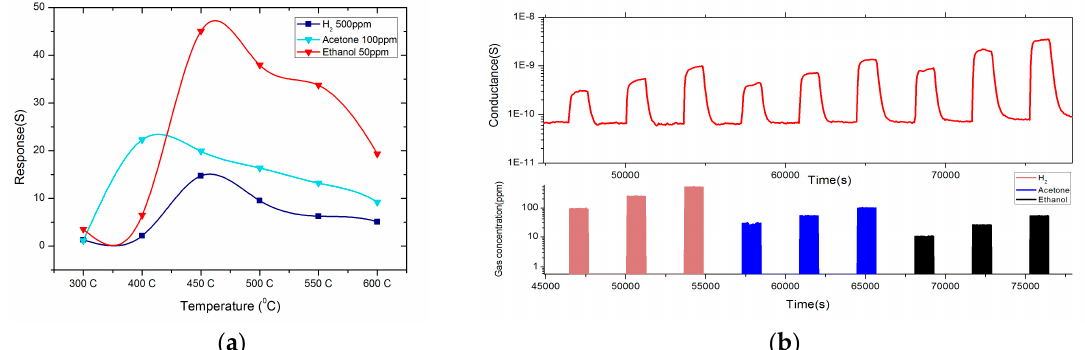
Figure 3. ( a ) Dynamic response of MoO 3 nanostructures toward H 2 , Acetone and Ethanol at 450 °C.; ( b ) Response towards H 2 , Acetone and Ethanol in different working temperatures. RH = 40%, at 20 °C, with an applied voltage equal to 1 V.